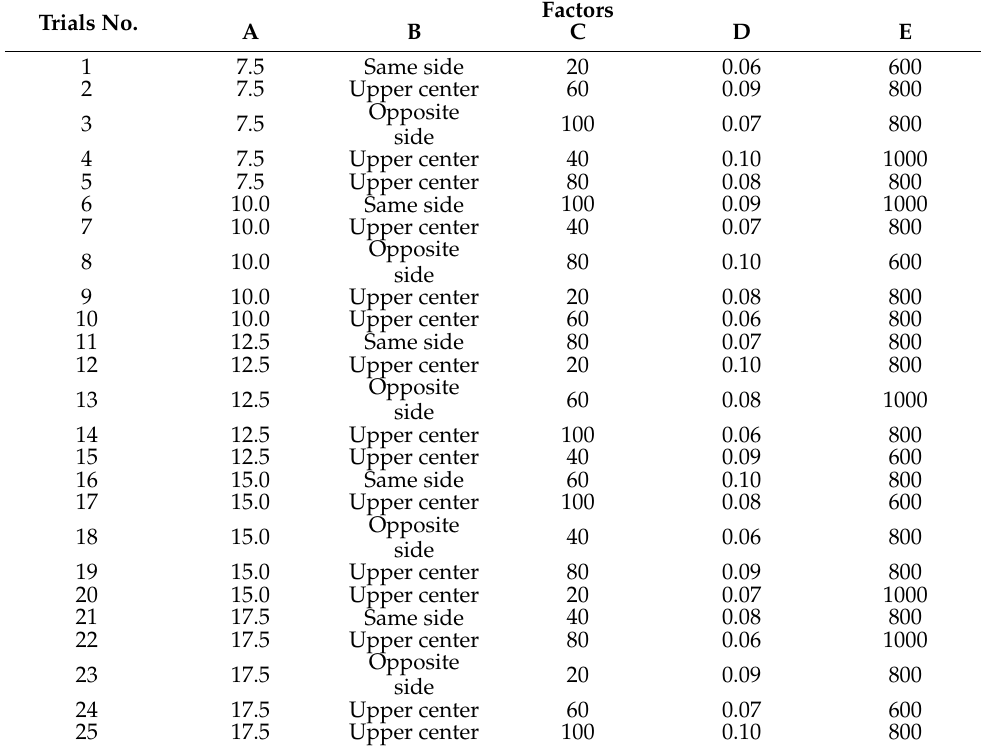
Table 1. The mixed-level orthogonal experiments scheme of L 25 (5 3 · 3 2 ) . Trials